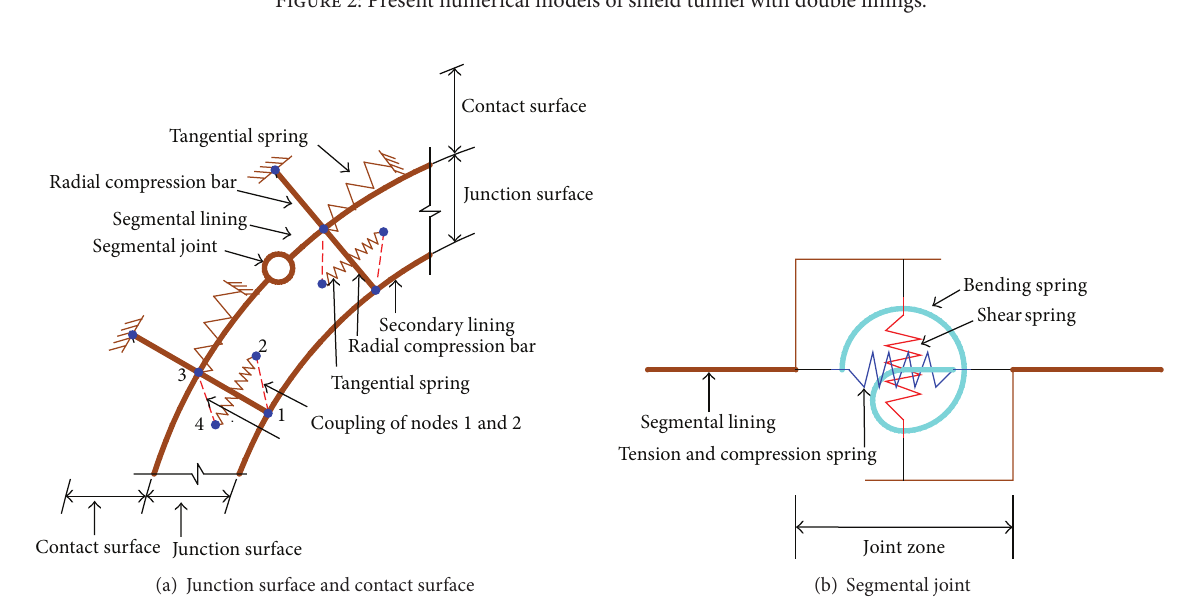
Figure 2: Present numerical models of shield tunnel with double linings.